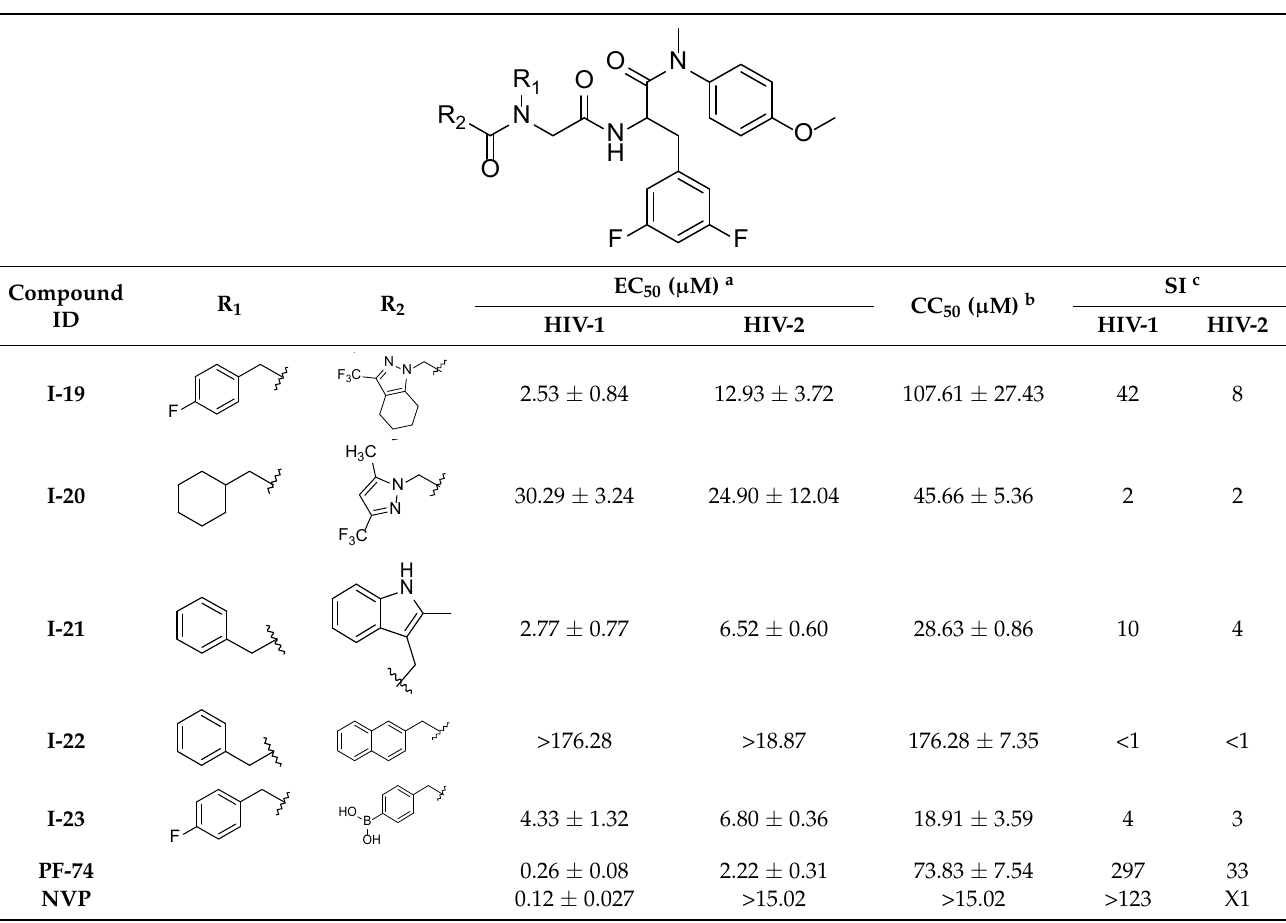
Table 1. Cont. Table 1. Anti-HIV-1/HIV-2 activity of novel phenylalanine